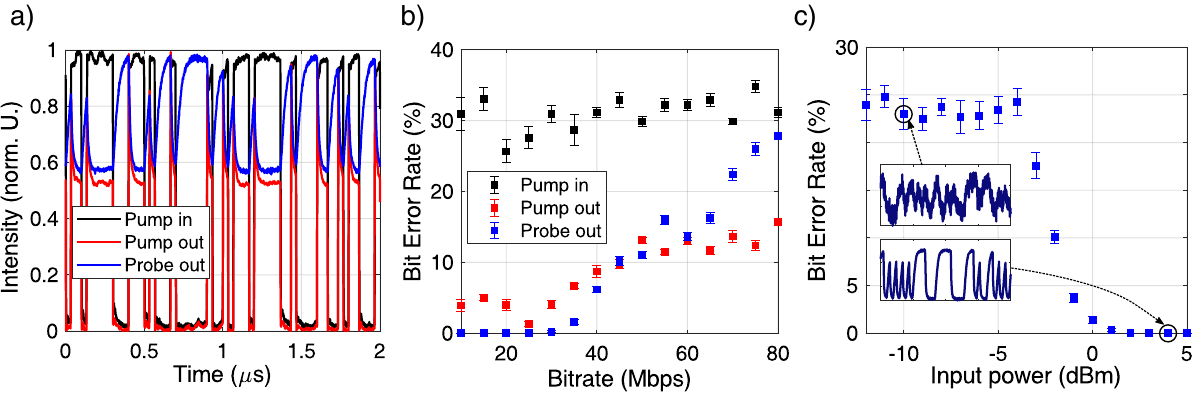
Figure 3. ( a ) Examples of waveforms processed during the XOR task. The pump laser driving the input port of the MR is shown in black, while the pump and probe outputs from the Drop port are respectively shown in red and blue. ( b ) Bit Error Rate (BER) as a function of the bitrate for the 1-bit delayed XOR task. Black dots use a predictor matrix X whose entries are sampled from the input pump power. Red and blue dots use respectively predictors sampled from the pump and the probe traces at the Drop port of the MR. In all the three cases, the average pump power is set to 3dBm . ( c ) Bit Error Rate as a function of the average pump power for a fixed bitrate of 20Mbps . The insets show details of the probe waveform at the pump powers − 10 dBm and 4 dBm